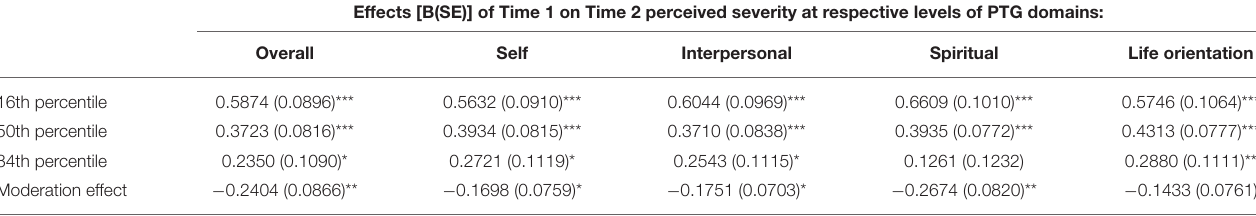
TABLE 6 | Effects of Time 1 perceived severity on Time 2 perceived severity at 16th, 50th, and 84th percentile of post-traumatic growth and its subscales ( N =